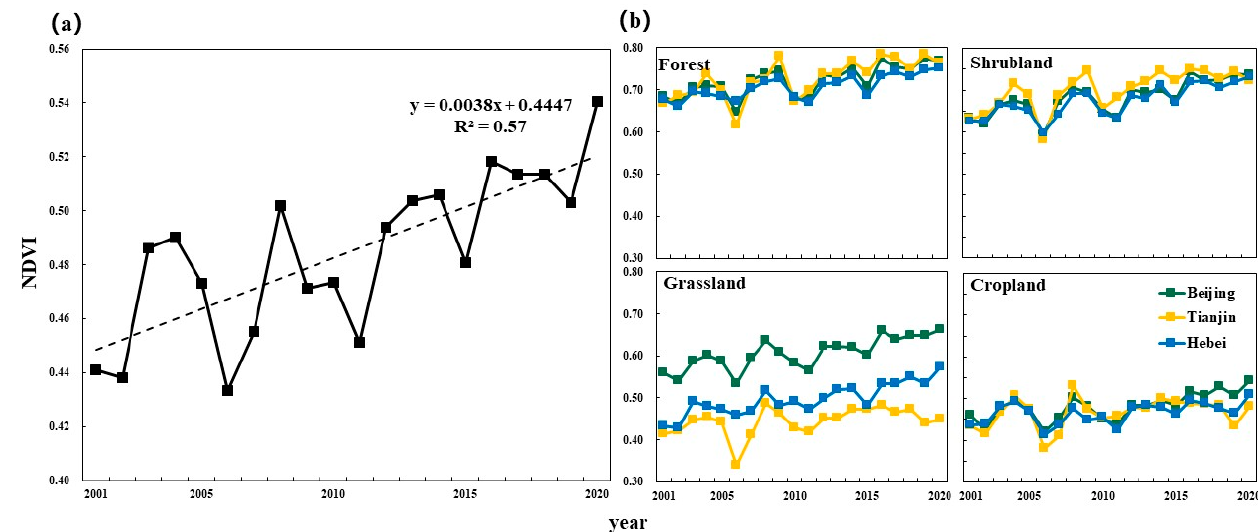
Figure 5. Changes in the average value of growing season NDVI in the Beijing–Tianjin–Hebei region, (( a ) average value of growing season and ( b ) growing season average value of four landcover types). The temporal change of four vegetation types in Beijing, Tianjin, and Hebei are consis-